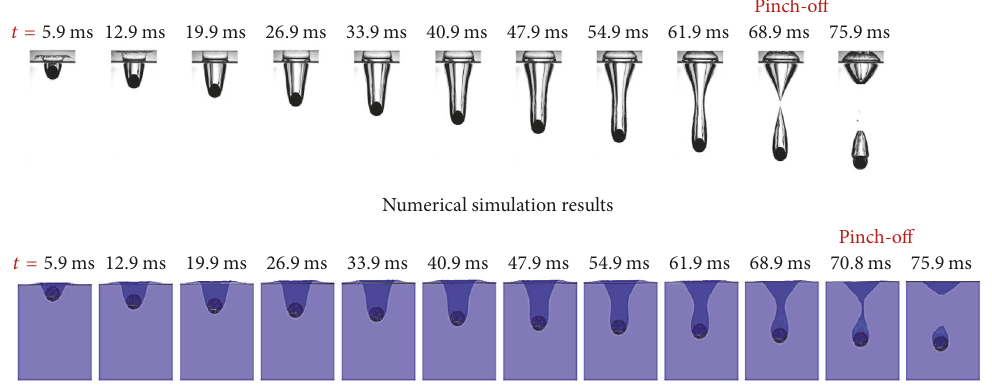
Figure 4: Comparison of numerical results with experimental photographs of Aristoff et al. [10] for the sphere water entry problem.